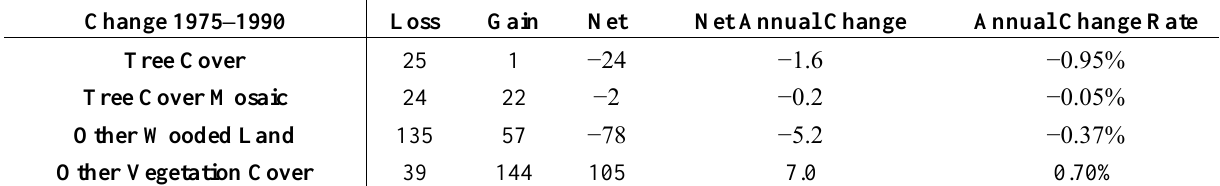
Table 2. Land cover dynamics (Loss, Gain and Net change) between 1975 and 1990 in West Africa represented by areas of change in thousands of km 2 . Annual change rates are computed comparing the areas in the 1975 and 1990 reference years.